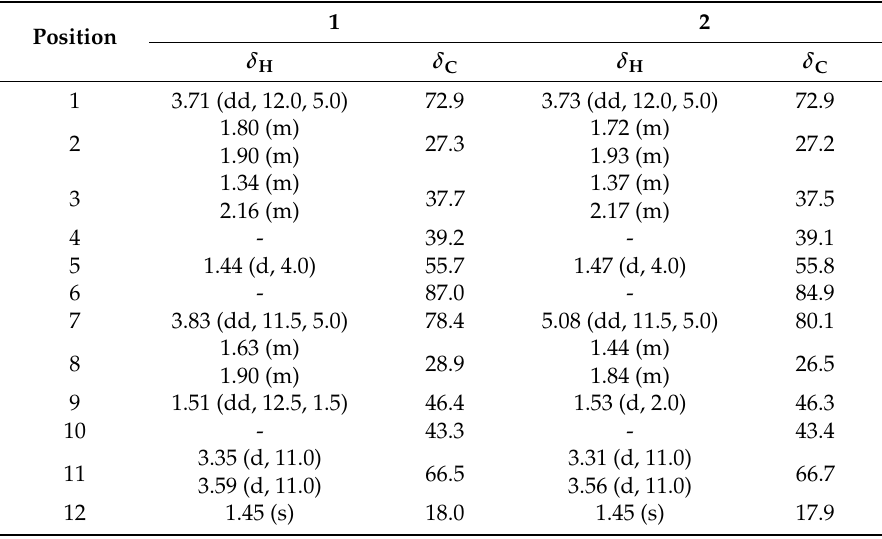
Table 1. 1 H and 13 C NMR data of compounds 1 and 2 in CD 3 OD ( δ in ppm, J in Hz) a .